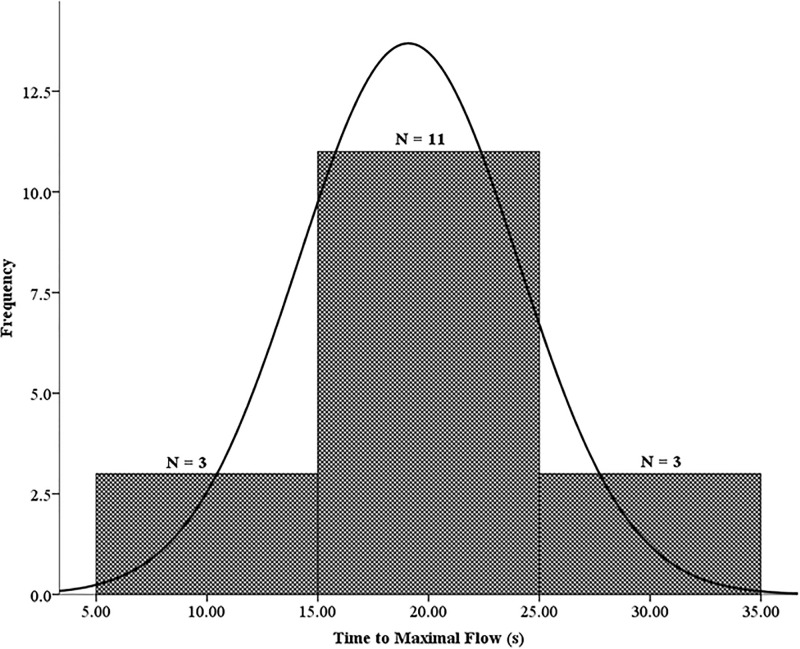
Average TMF (19.1 ± 4.9s) of the three PORH responses (VA, VB1, VB2).These data were normally distributed. The skewness and kurtosis were -0.064 and -0.642, respectively.